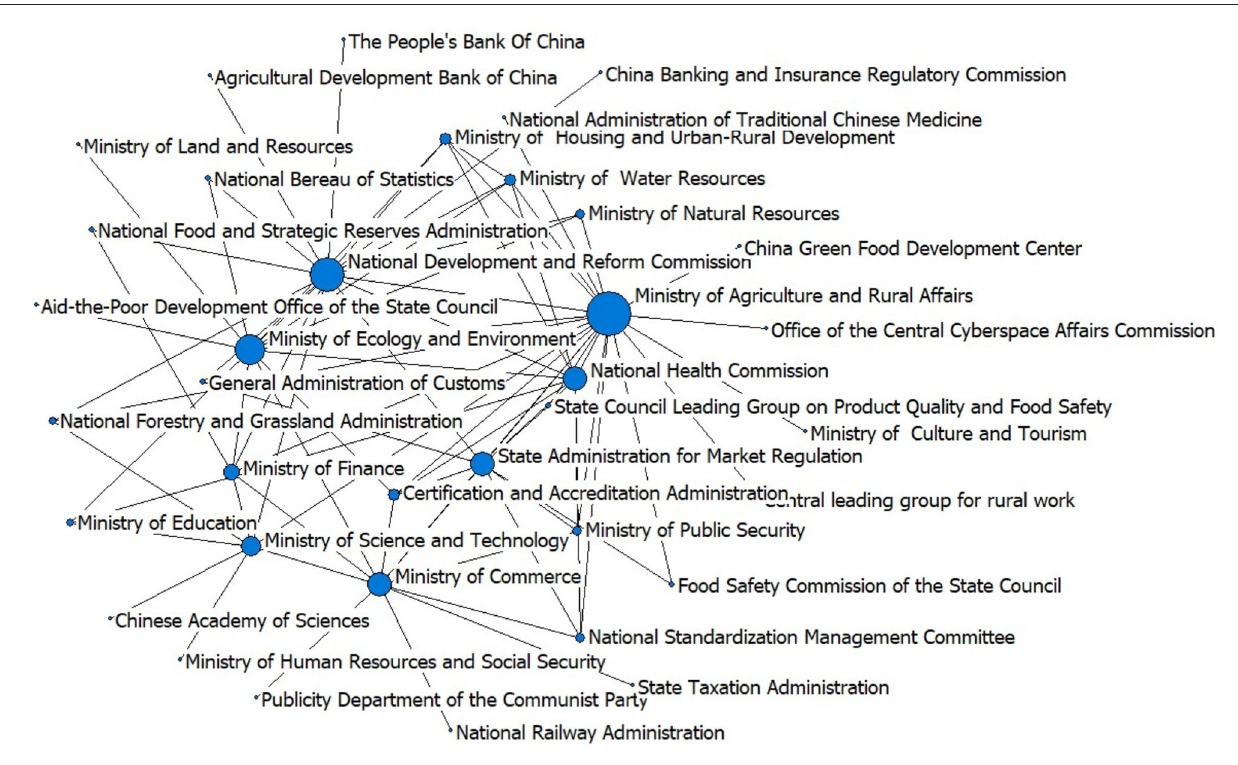
FIGURE 9 | The cooperative network in jointly published policy